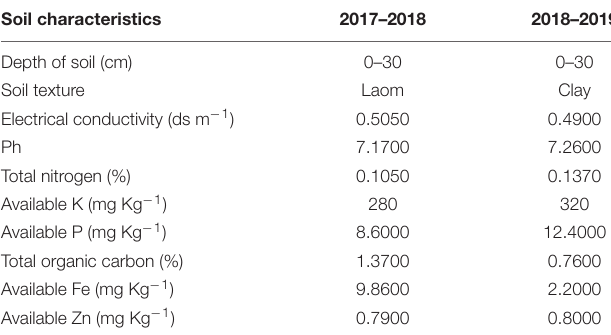
TABLE 1 | Physicochemical properties of the soil before sowing seed in two seasons of experiment (2017–2018 and